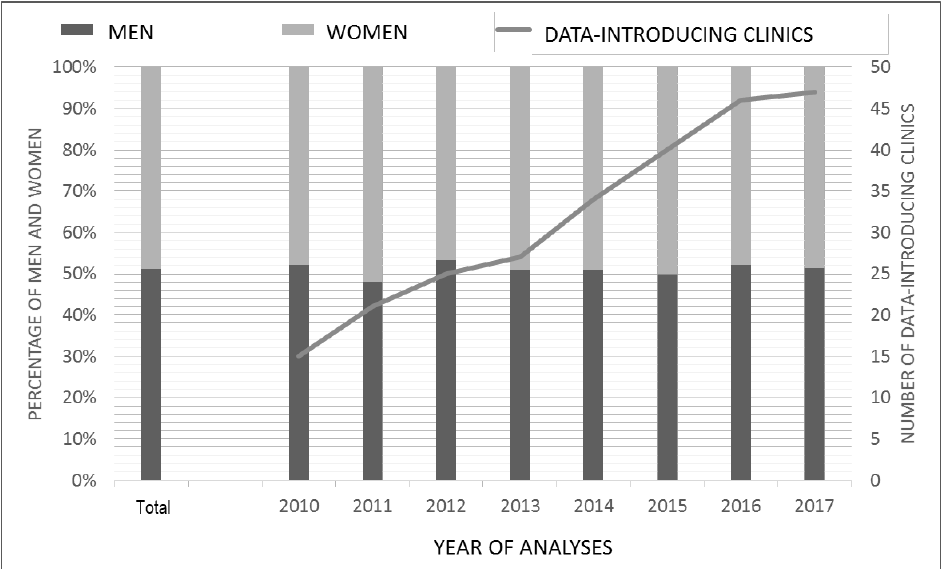
Figure 2. Gender distribution of all appendicitis cases (adults) and number of data introducing clinics, 2010–2017 ( n = 19,749).